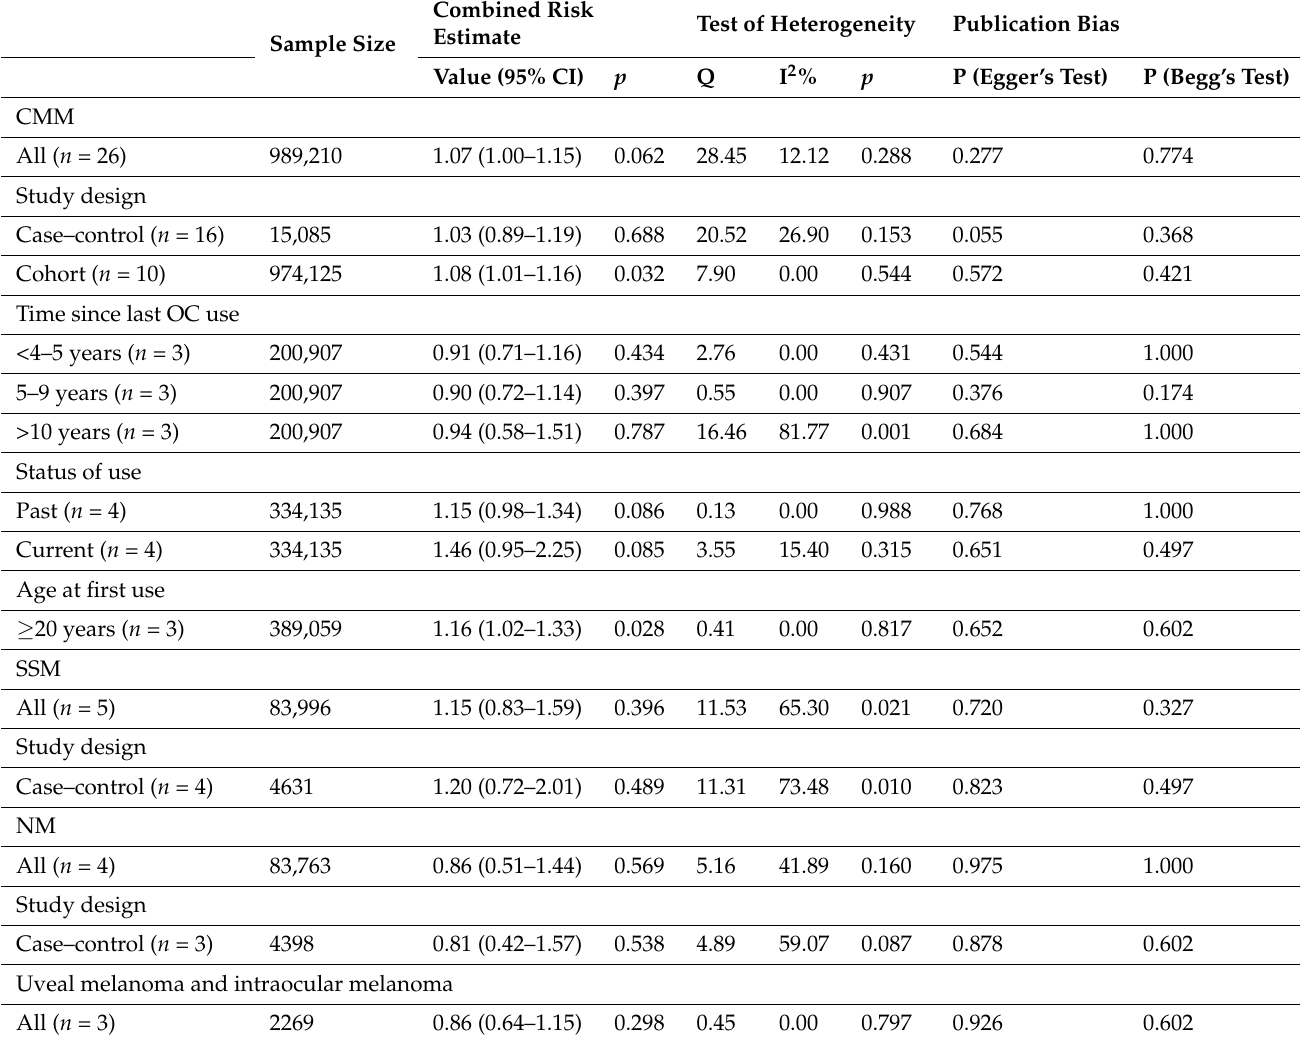
Table 1. Results of stratified analysis of malignant melanoma risk estimates for use of oral contracep- tives (OCs). Reference category: no OC